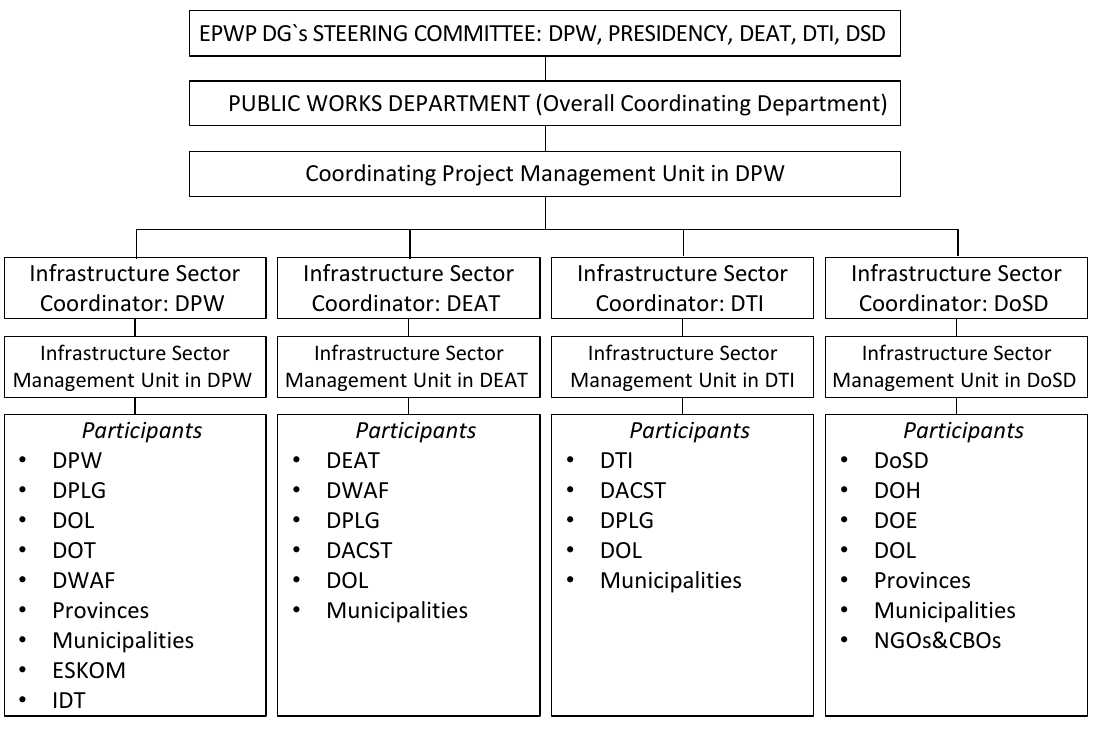
Figure 2. EPWP Monitoring and Evaluation